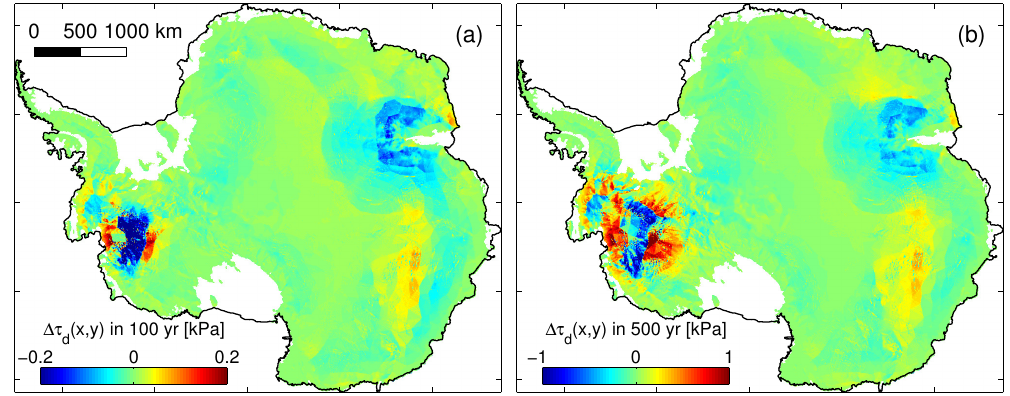
Figure 6. Influence of GIA uplift on the gravitational driving stress. Change in driving stress, 1τ d (x,y) , due to the predicted bed uplift at (a) AD 2100 and (b) AD 2500. Calculations are made for the current distribution of ice thickness. Negative magnitudes imply that surface slopes flatten in the future. As the GIA solutions only perturb the ice–bedrock contact area, we mask out the ice shelves in the